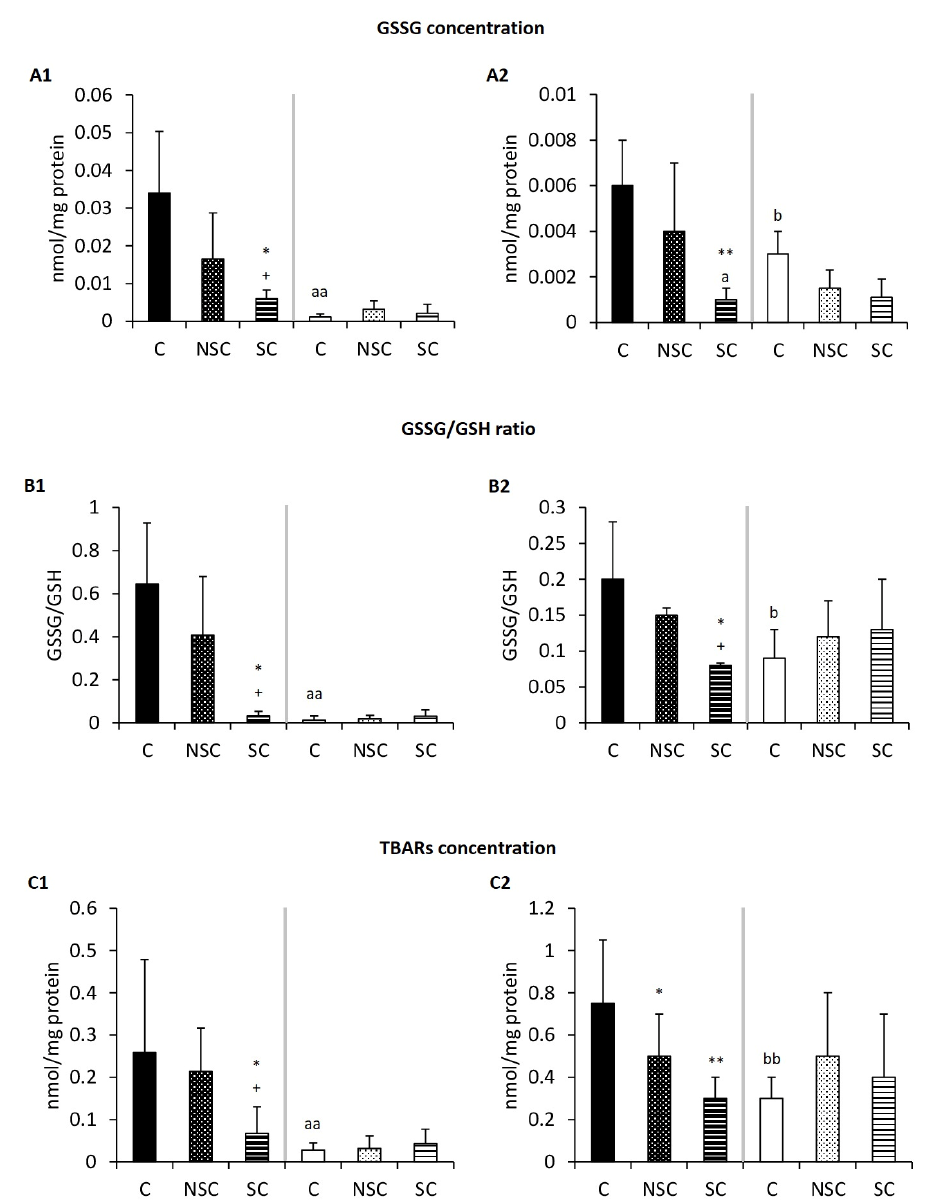
Figure 3. Changes in oxidative parameters in peritoneal leukocytes. ( A ) GSSG concentration in nmol/mg protein. ( B ) GSSG/GSH ratio. ( C ) TBARs concentration in nmol/mg protein. The results corresponding to peritoneal leukocytes from chronologically adult and old mice are shown in A1, B1, and C1, and from adult prematurely-aging mice (PAM) and non-prematurely-aging mice (NPAM) are shown in A2, B2, and C2. Each column shows mean ± standard deviation of 6–15 values corresponding to the same number of animals. After a statistical analysis comparing means with the Student’s t-test for independent samples, significant differences were observed in the indicated experimental groups *: p < 0.05, **: p < 0.01 with respect to the values obtained in their corresponding control group. +: p <0.05 with respect to the values obtained in the corresponding NSC group. aa: p < 0.01 with respect to the values obtained in old mice C. b: p < 0.05, bb: p < 0.01 with respect to the values obtained in PAM C. C: control group (old mice/PAM: n = 6; adult mice/E-NPAM: n = 7). NSC: non-skin-to-skin contact (old mice/PAM: n = 6; adult mice/E-NPAM: n = 15). SC: skin-to-skin contact (old mice/PAM: n = 6; adult mice/E-NPAM: n = 15). GSSG: oxidized glutathione. GSH: reduced glutathione. TBARs: thiobarbituric acid reactive substances.